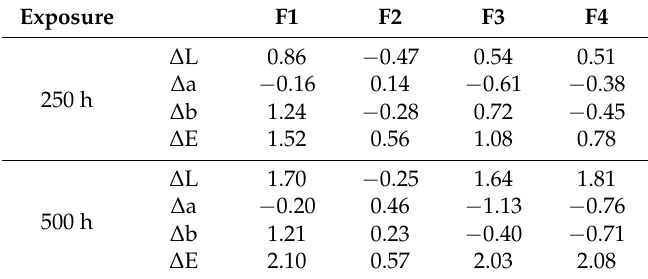
Table 3. Colour change due to UV weathering.